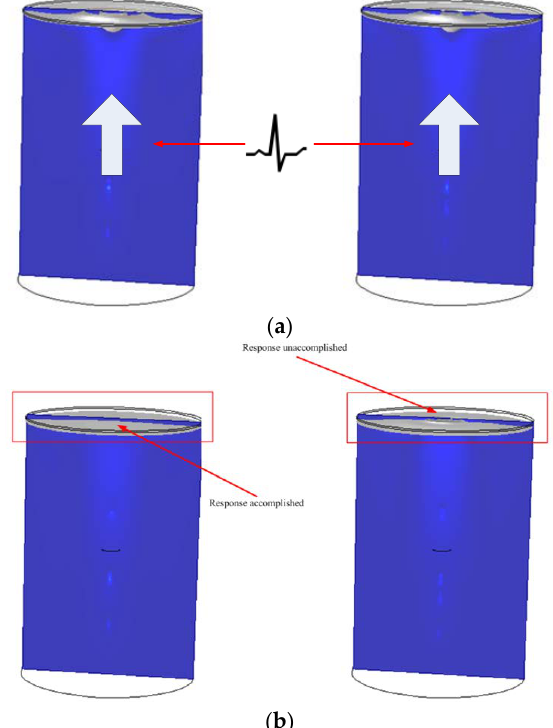
Figure 5. The performance of the different membrane thicknesses under the same Gaussian pulse signal excitation. ( a ) 0–0.3 s, the same pulse signals are imposed on the 1.5 mm thick membrane ( left ) and on the 1.0 mm thick membrane ( right ); ( b ) 0.3–0.5 s, the response of the reaction cavity with a membrane thickness of 1.0 mm is not determined.